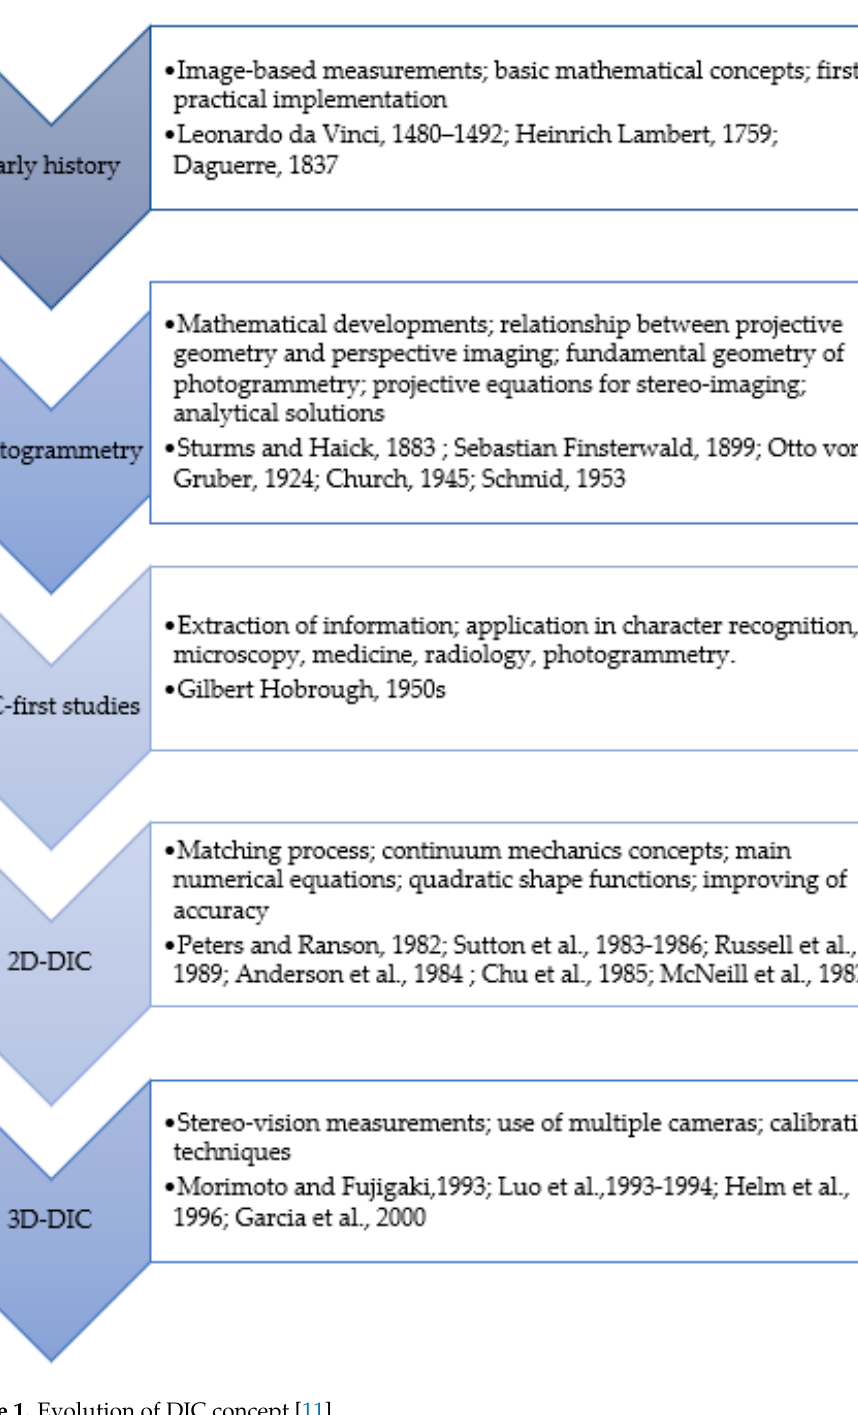
Figure 1. Evolution of DIC concept [11].